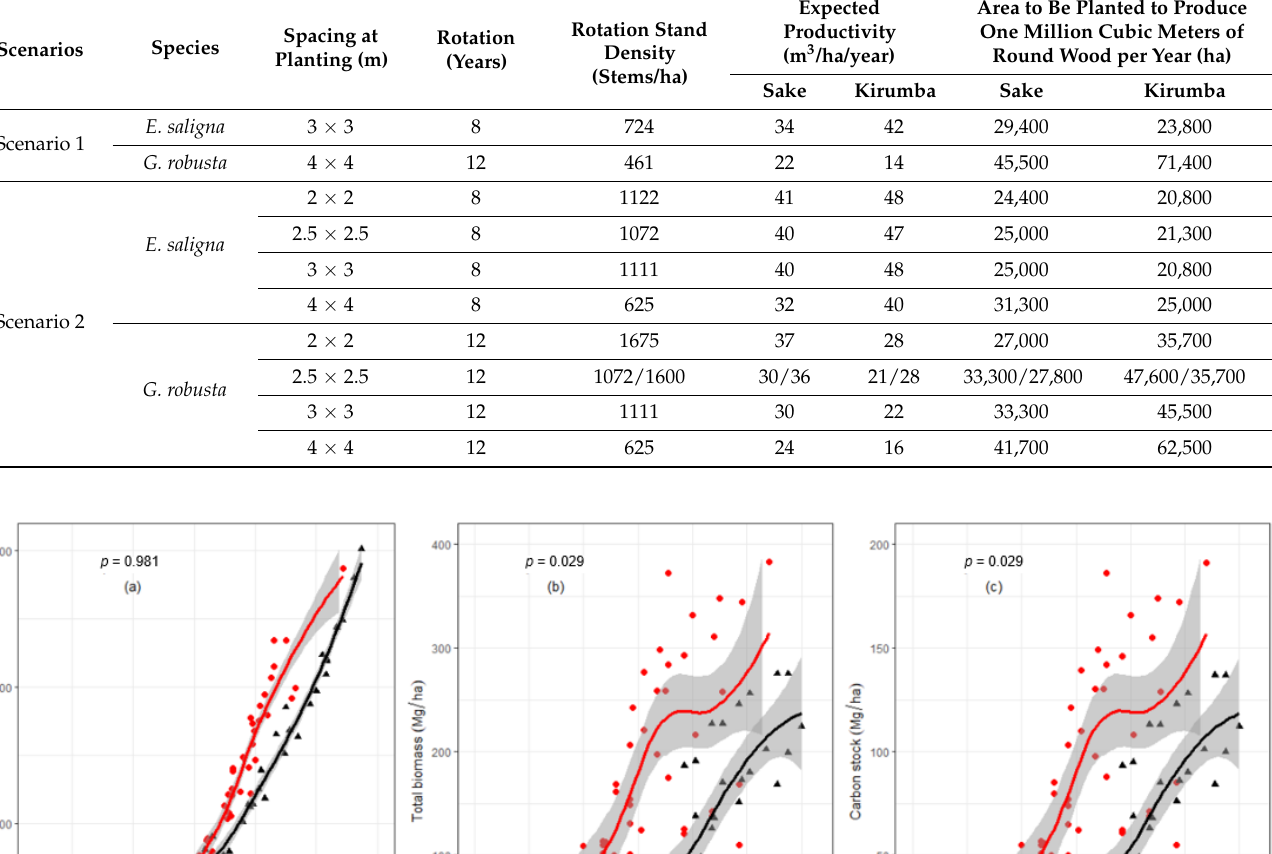
Table 5. Expected productivity over the rotation and area to be dedicated to plantations. Expected productivities were calculated from Models 3 and 8 (Table 3). The area to be dedicated to plantations was estimated from Equation (14). The rotation stand density corresponds to the stand density after thinning (see Table 4).